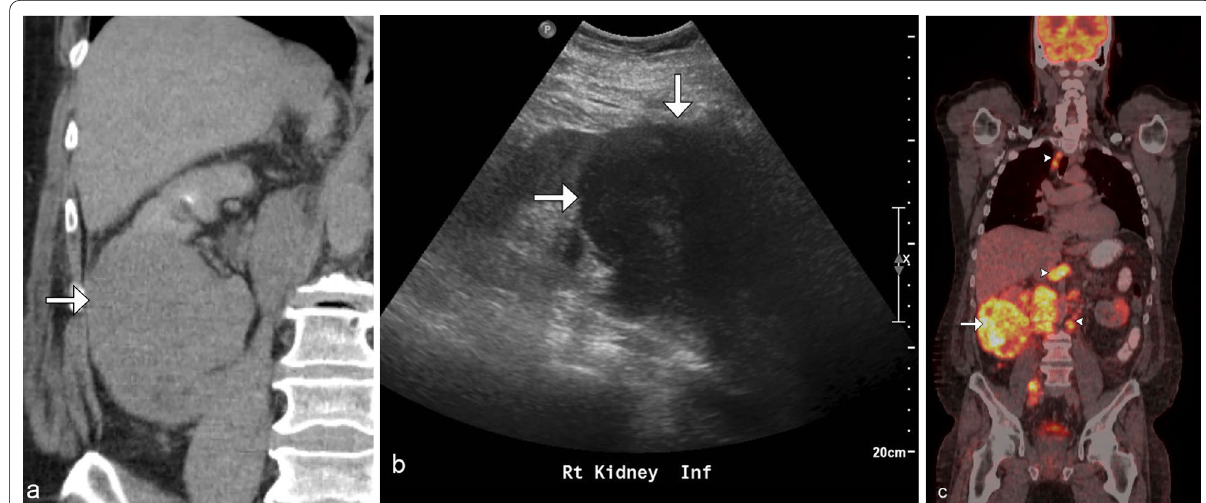
Fig. 3 Solitary mass of renal lymphoma. Coronal CT delayed post contrast image ( a ) demonstrates a hypoenhancing right lower pole renal mass with hypoechoic appearance on ultrasound ( b ) and marked F18-FDG avidity on PET/CT ( c ) (arrows). Additional FDG avid supradiaphragmatic and extensive infradiaphragmatic lymphadenopathy is helpful in confirming the diagnosis of lymphoma